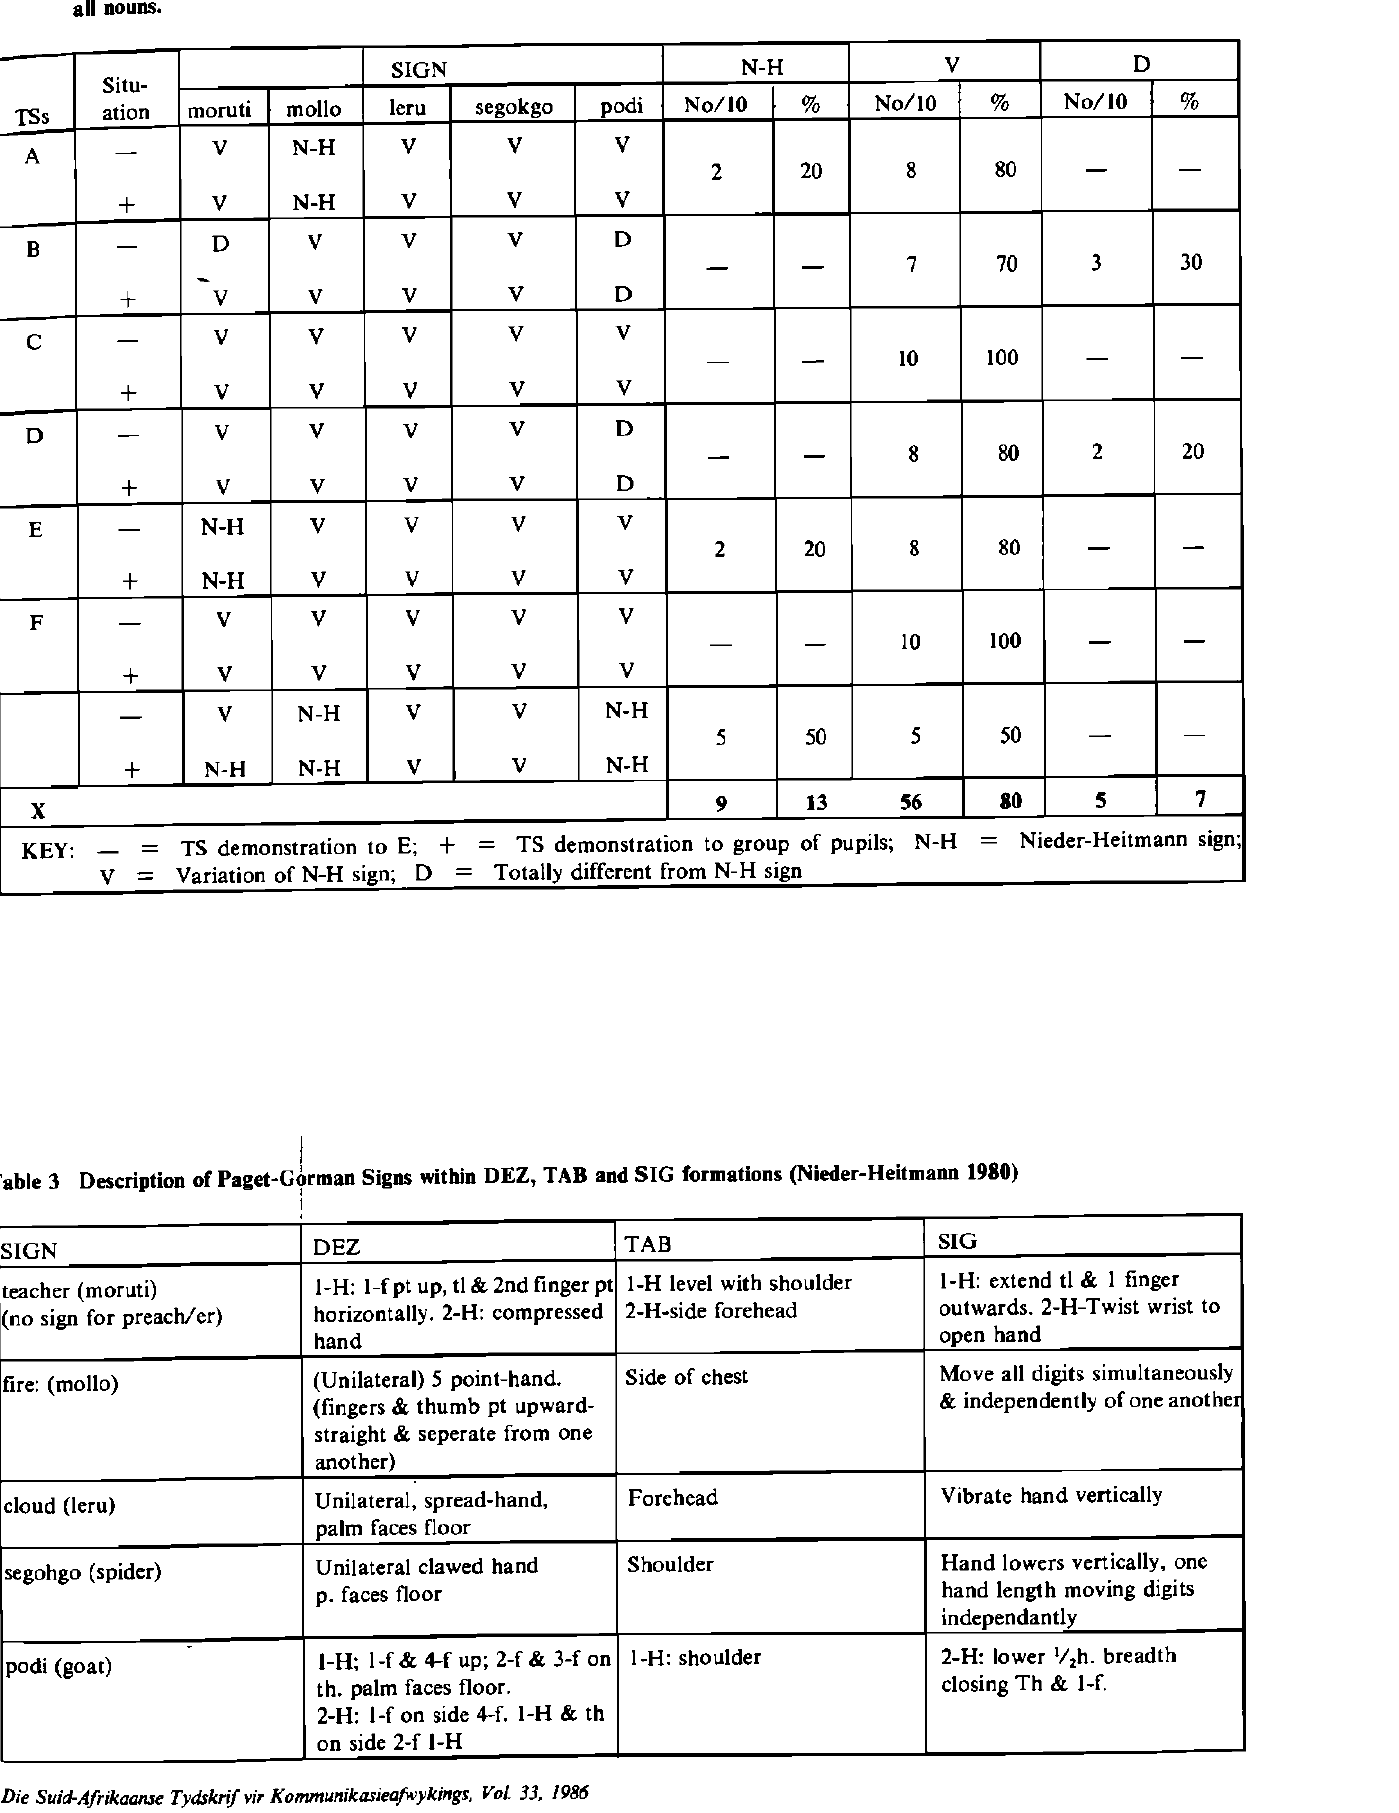
Table 3 Description of Paget-Gorman Signs within DEZ, TAB and SIG formations (Nieder-Heitmann 1980)